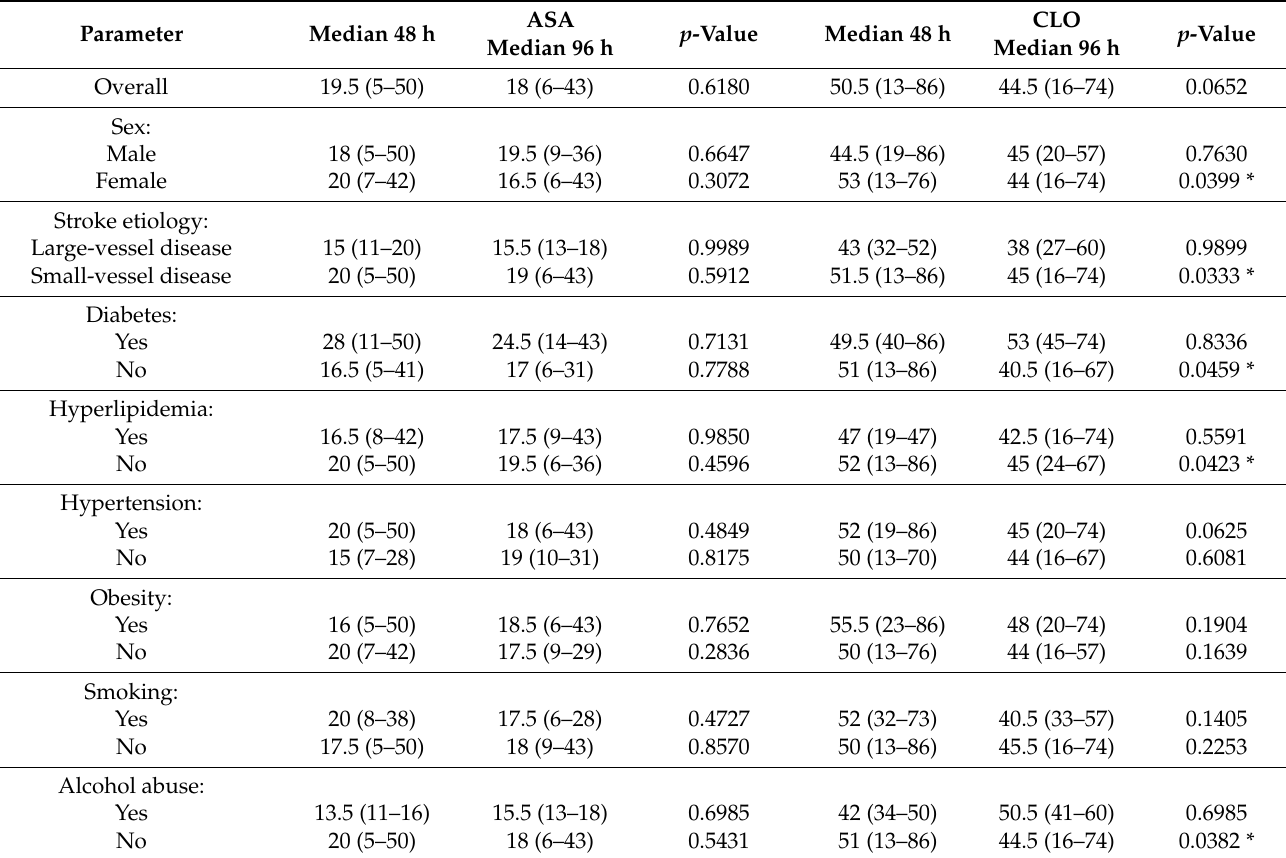
Table 4. Comparison of the dynamics of platelet reactivity between aspirin and clopidogrel in the minor stoke group with dual antiplatelet